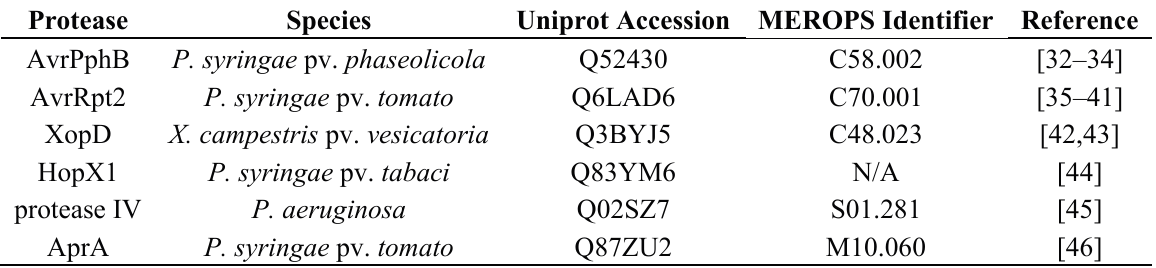
Table 2. Pathogen-secreted proteases whose functions in interactions with Arabidopsis have been partially